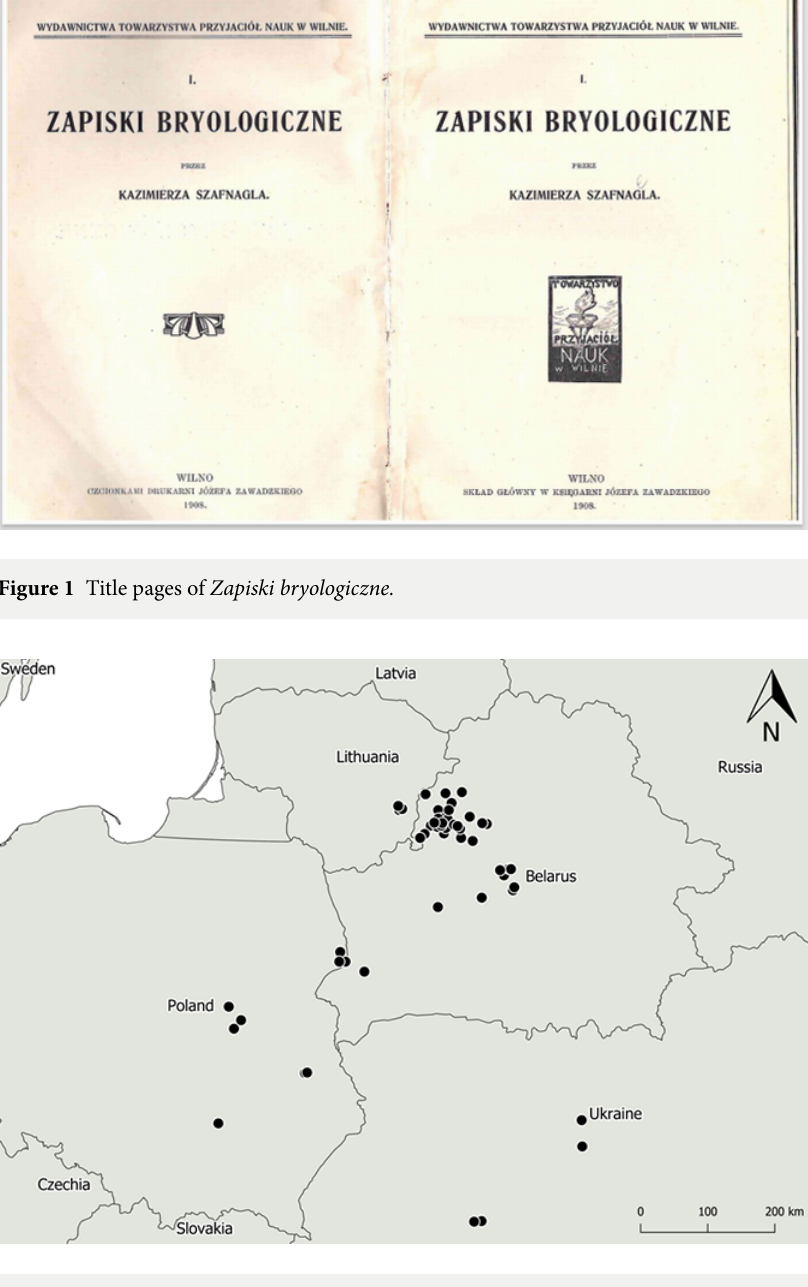
Figure 2 Map showing the locations explored by K.